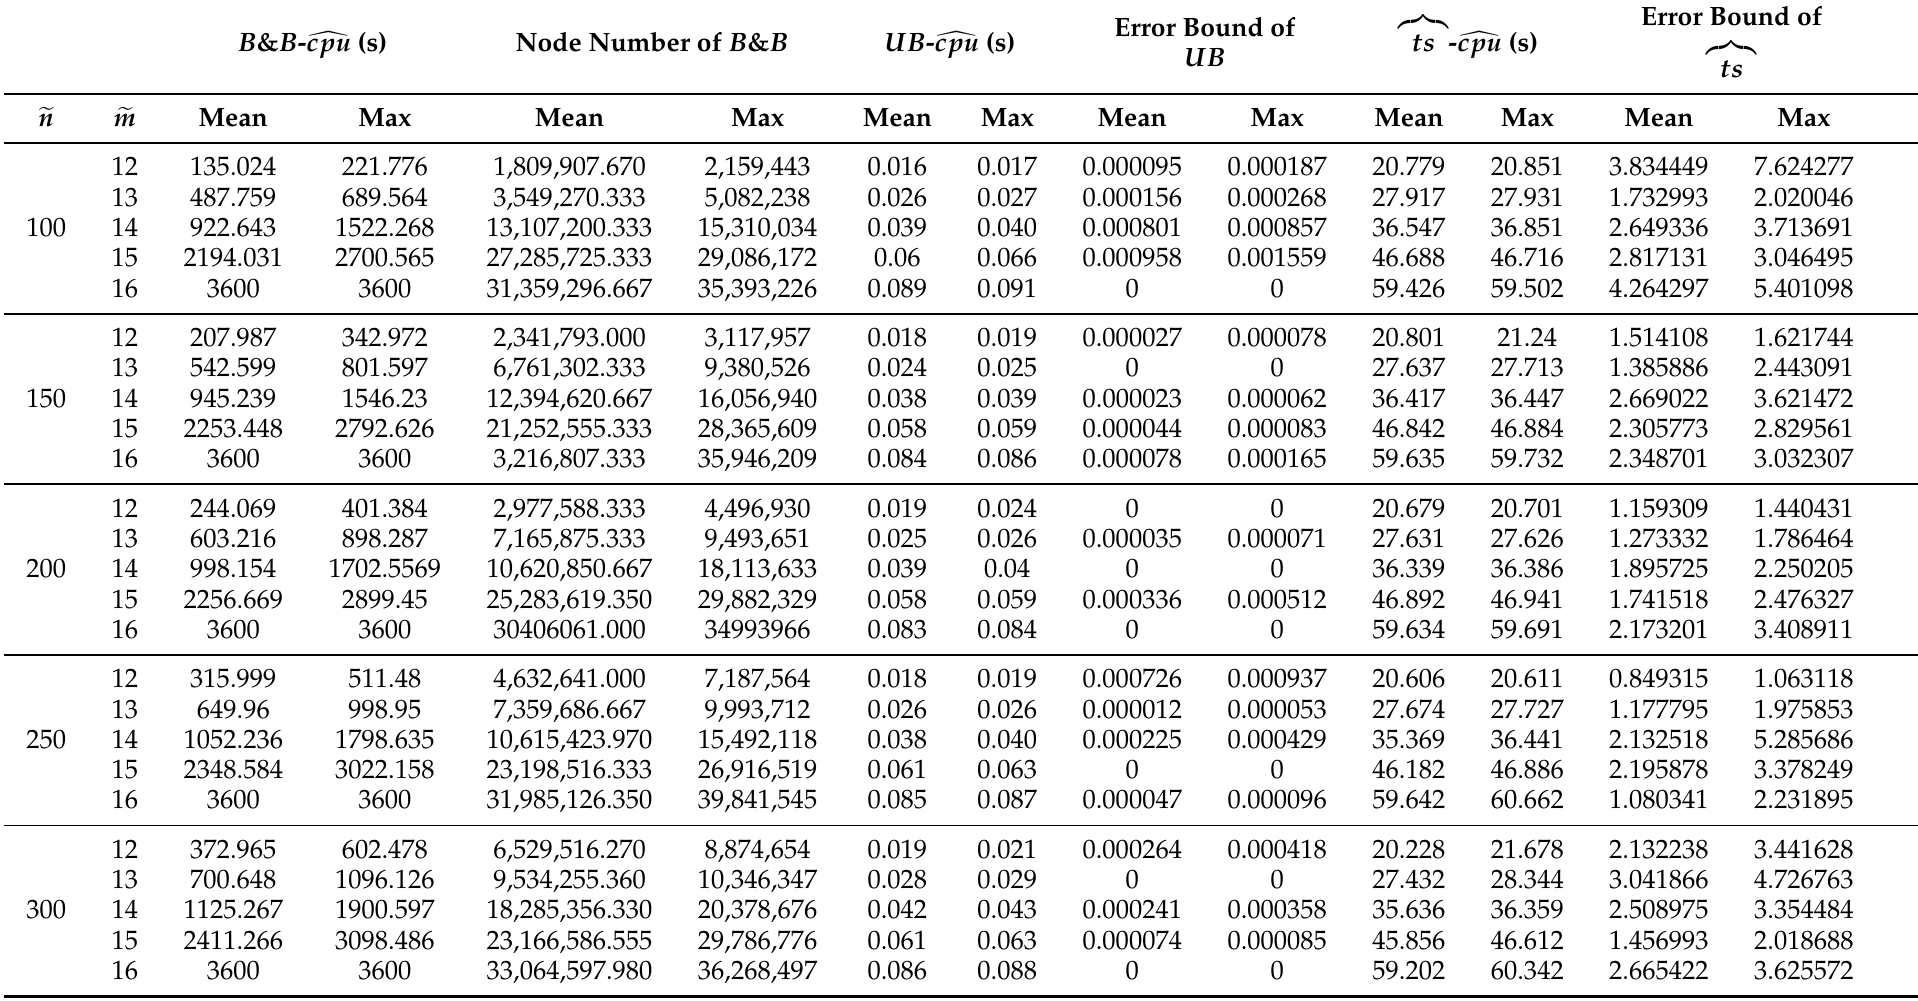
Table 2. Results of algorithms for θ , µ ∼ ( 0,0.5 )